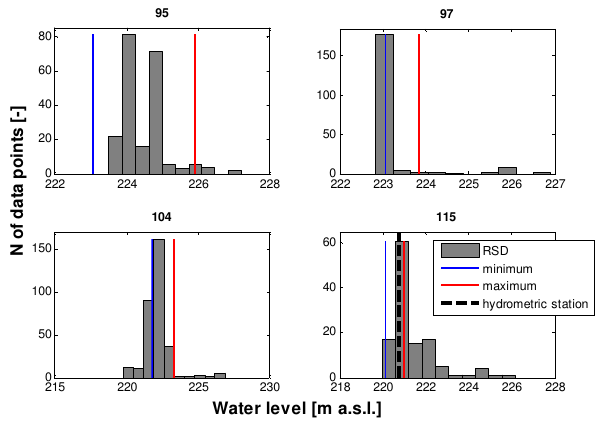
Fig. 6. Cross section specific empirical histograms of RSD water levels for four hydrometric sections, shown with numbers increas- ing in river flow direction, for the first satellite overpass (ERS-2 on 2 January 2003 at 22.00 GMT+1). RSD, minimum, maximum and station recorded water levels (where available) are also